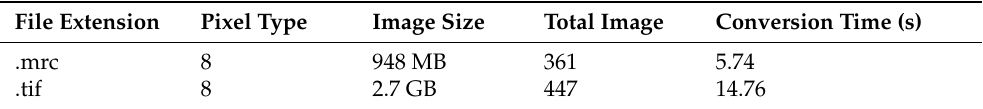
Table 3. FIB-SEM conversion pipeline performance of two distinct FIB-SEM image files into stan- dard DICOM.